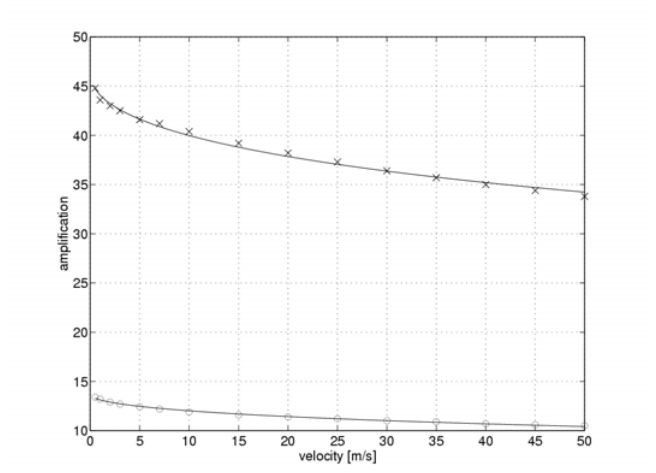
Figure 3. Simulated optimal values of the measuring system controller gains k "o" - k CL